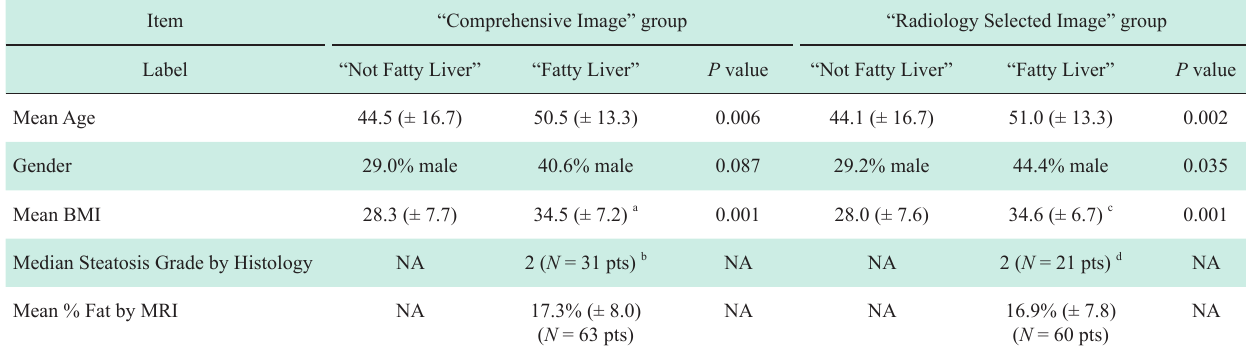
Table 3 Univariate analysis of patients enrolled in each image